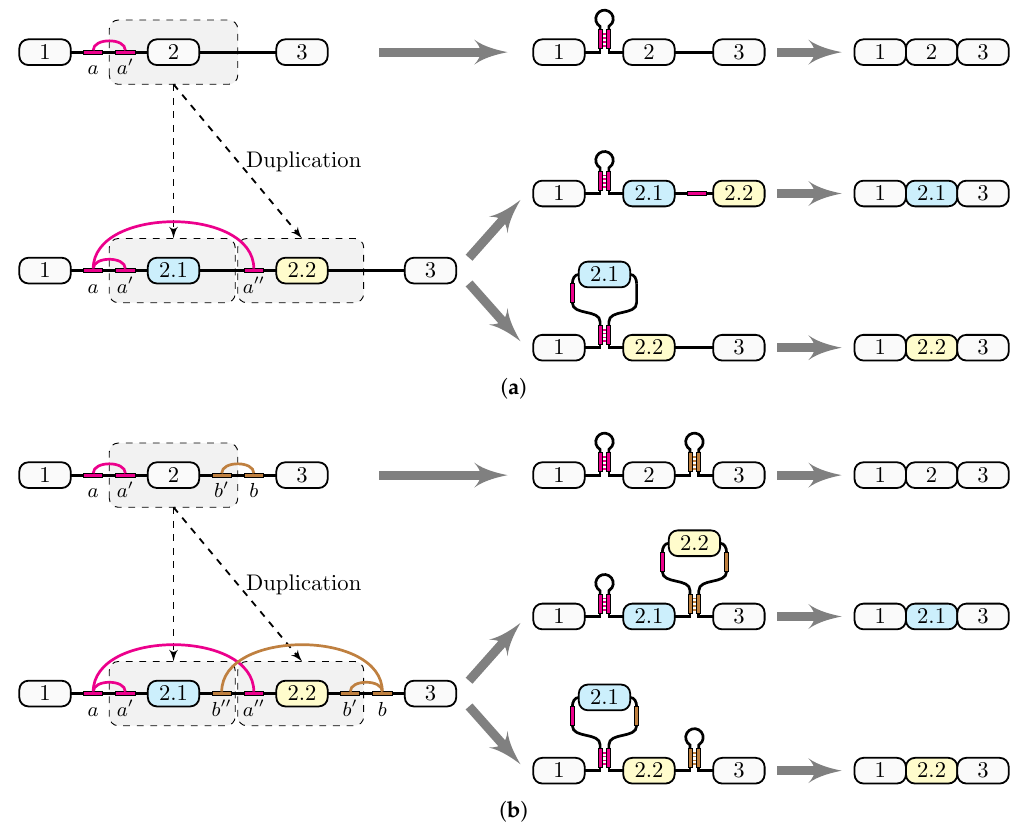
Figure 3. Generation of competing RNA structures through a genomic duplication. ( a ) If a genomic duplication affects an exon and one arm of the stem-loop located in the flanking intron, it creates a pair of competing complementary sequences that loop out exon 2.1. ( b ) If the genomic duplication affects the exon and the adjacent parts of its two flanking introns, each containing one arm of a stem-loop, it will create a pair of competing complementary sequences, each looping out one of the exons 2.1 and 2.2. Notably, the arrangement of complementary parts is exactly as suggested in the bidirectional model in the srp gene